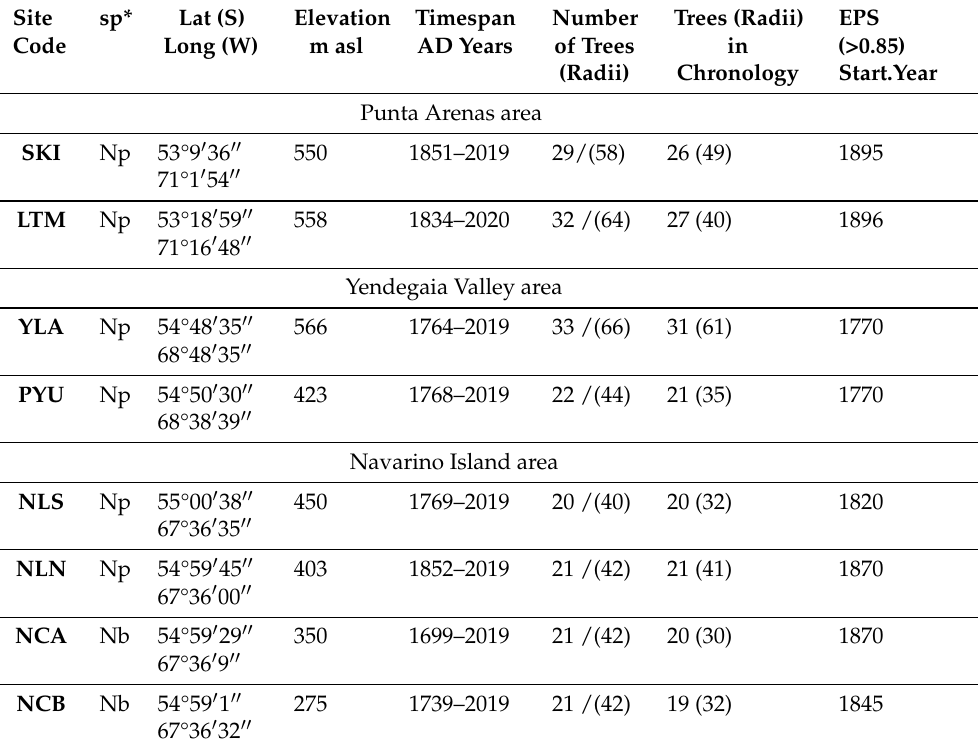
Table 1. Sampling-sites main characteristics. Np = N. pumilio ; Nb = N. betuloides . sp* =